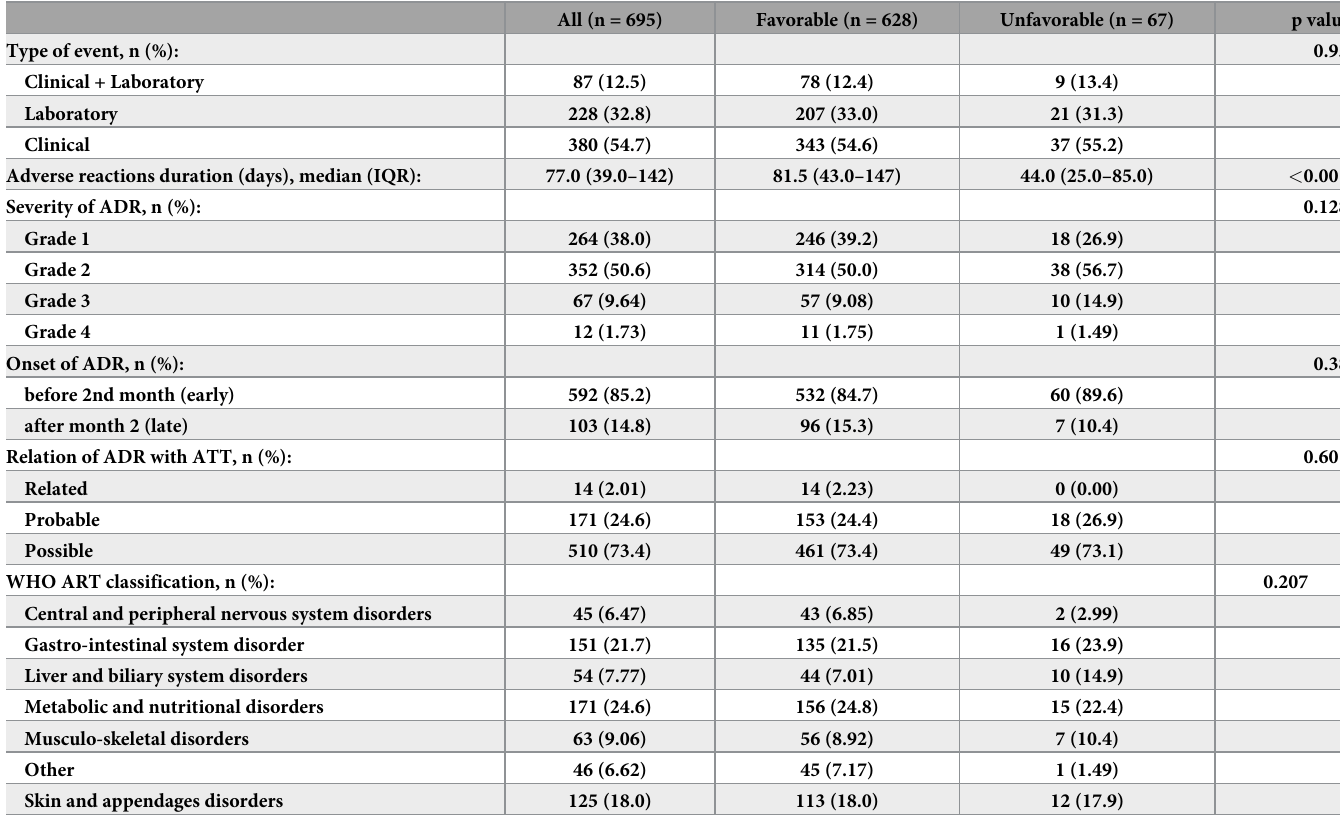
Table 2. ADR characteristics according to ATT